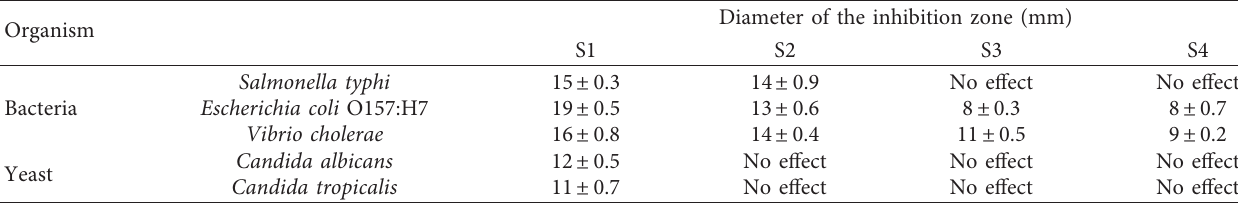
Table 4: Diameters of inhibition zones (DI) of vinegar samples.